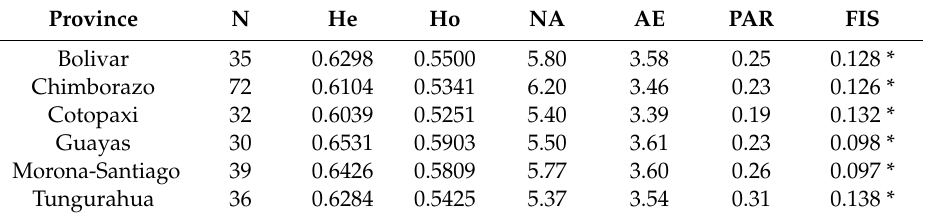
Table 2. Genetic diversity parameters of the Ecuadorian chicken breed in each province. Province N He Ho NA AE PAR FIS Bolivar 35 0.6298 0.5500 5.80 3.58 0.25 0.128 * Chimborazo 72 0.6104 0.5341 6.20 3.46 0.23 0.126 * Cotopaxi 32 0.6039 0.5251 5.40 3.39 0.19 0.132 * Guayas 30 0.6531 0.5903 5.50 3.61 0.23 0.098 * Morona-Santiago 39 0.6426 0.5809 5.77 3.60 0.26 0.097 * Tungurahua 36 0.6284 0.5425 5.37 3.54 0.31 0.138